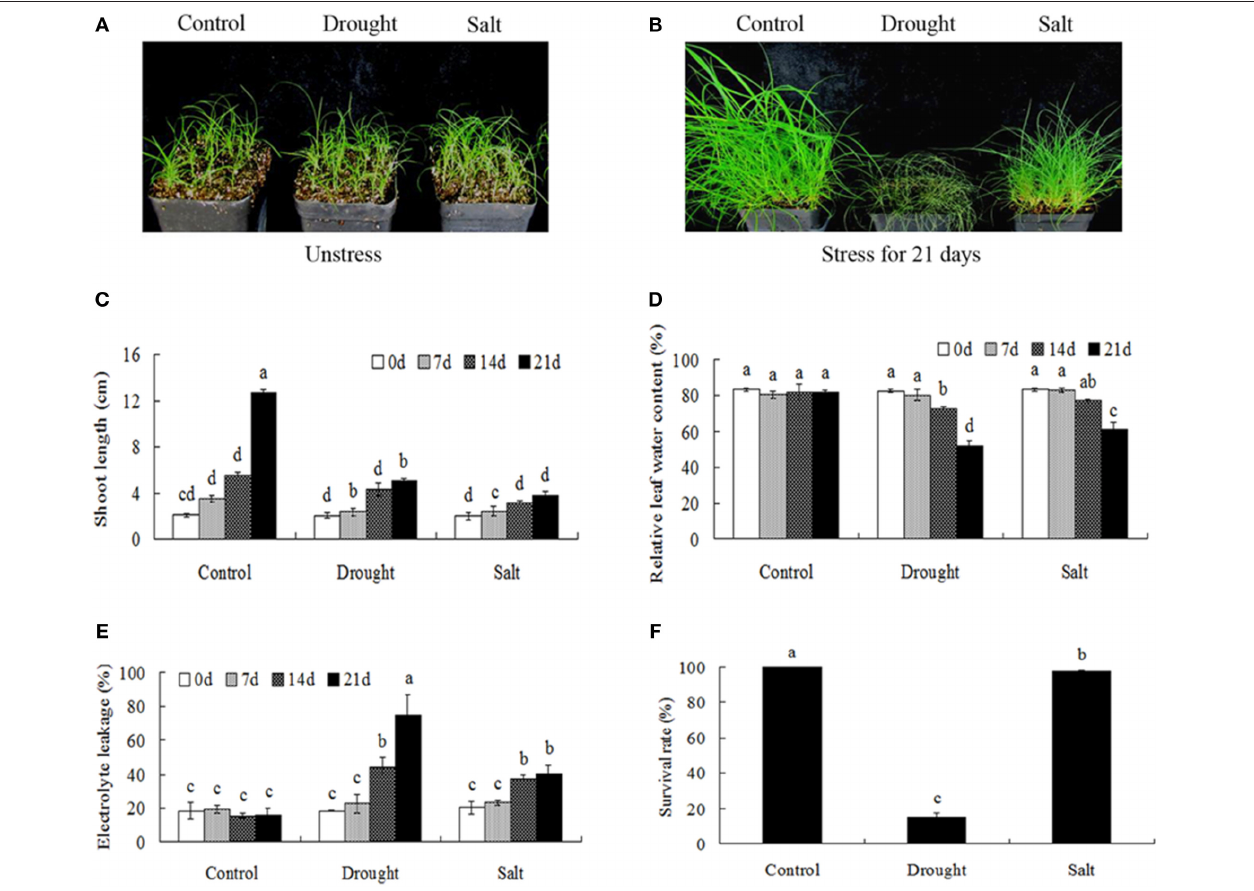
FIGURE 1 | Comparison of physiological responses to drought and salt in bermudagrass. (A) The photograph showing 3-week-old Bermudagrass that subjected to control condition and stress conditions for 21 days. Shoot length (B) , RWC (C) , chlorophyll content (D) , EL (E) of Bermudagrass under unstress and stress condition at designated time intervals. (F) Survival rate of Bermudagrass after 21 days of control and stress treatments. The data represent the means of three independent experiment ± SE, and data followed by different letters are significantly different from each other at P < 0.05 according to Duncan’s